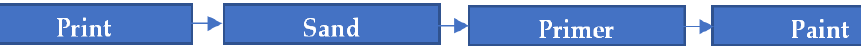
Figure 1. Conventional post-processing for the colourisation of 3D-printed parts.